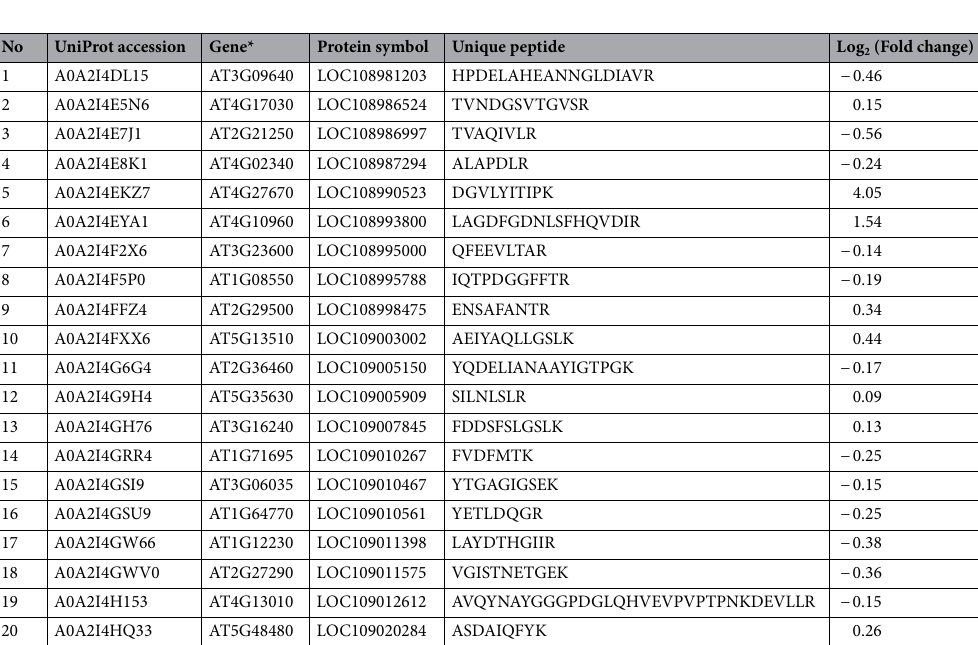
Table 2. PRM verification of DEPs in pecans after 48 h salt stress compared with controls. *Gene code was derived from Arabidopsis thaliana (TAIR10) (https:// www. arabi dopsis. org/ index. jsp). PRM, parallel reaction monitoring; DEPs, differentially expressed proteins. The related descriptions of these DEPs were shown in Table